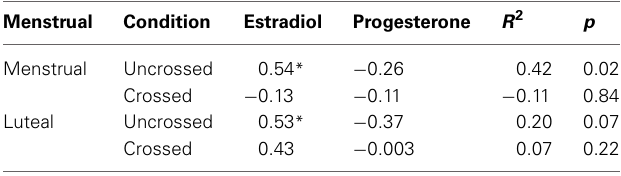
Table 5 | Multiple linear regression procedures (standardized β coefficients) for estradiol and progesterone levels as predictors of the CCE in the menstrual and the luteal phase for naturally cycling